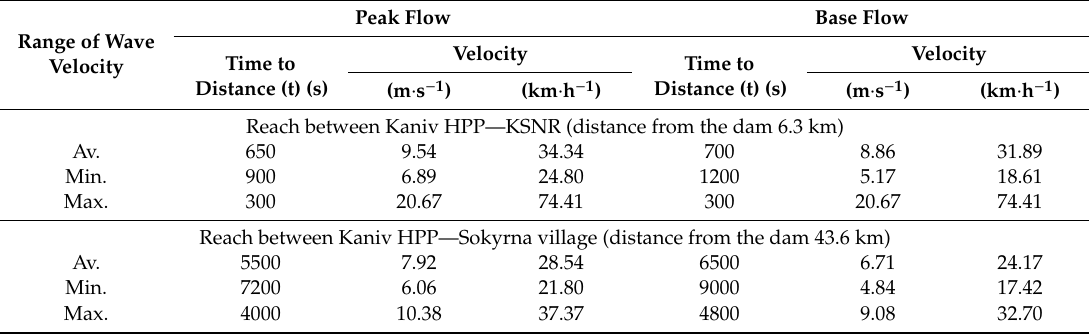
Table 2. Artificial wave propagation rate during peak flow and base flow of the Dnieper river below the Kaniv dam estimated for two selected reaches. Data obtained on July 24–26,